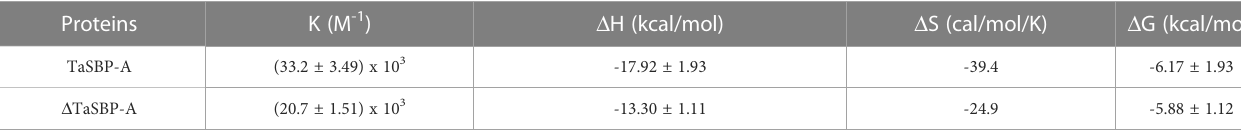
TABLE 1 Thermodynamic parameters calculated from micro-calorimetric experiments for the interaction between Cd 2+ and TaSBP-A/ D TaSBP-A at 25°C (298.15 K) in 10 mM HEPES, pH 7.4, 150 mM NaCl.